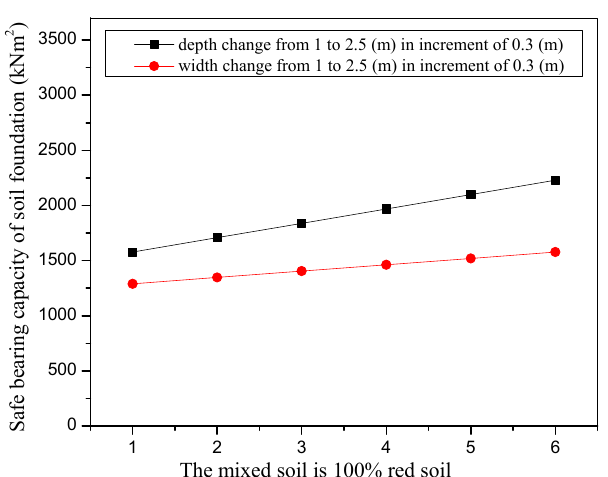
Figure 3: Fluctuation of safe bearing capacity of soil foundation (kN/m 2 ) Vs the mixed soil type.